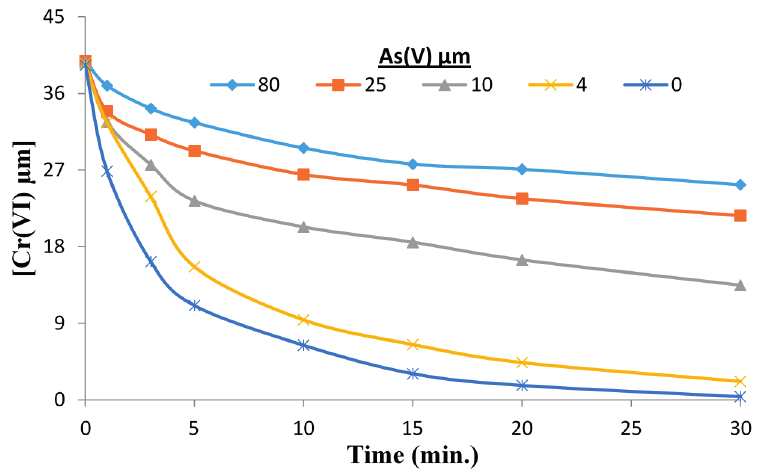
Figure 3. The reduction of Cr(VI) in the presence of As(V) at pH 3.0. [Cr(VI)] = 40 µM, [As(V)] = 0–80 µM, [TiO 2 ] = 0.10 g/L, 350 nm.